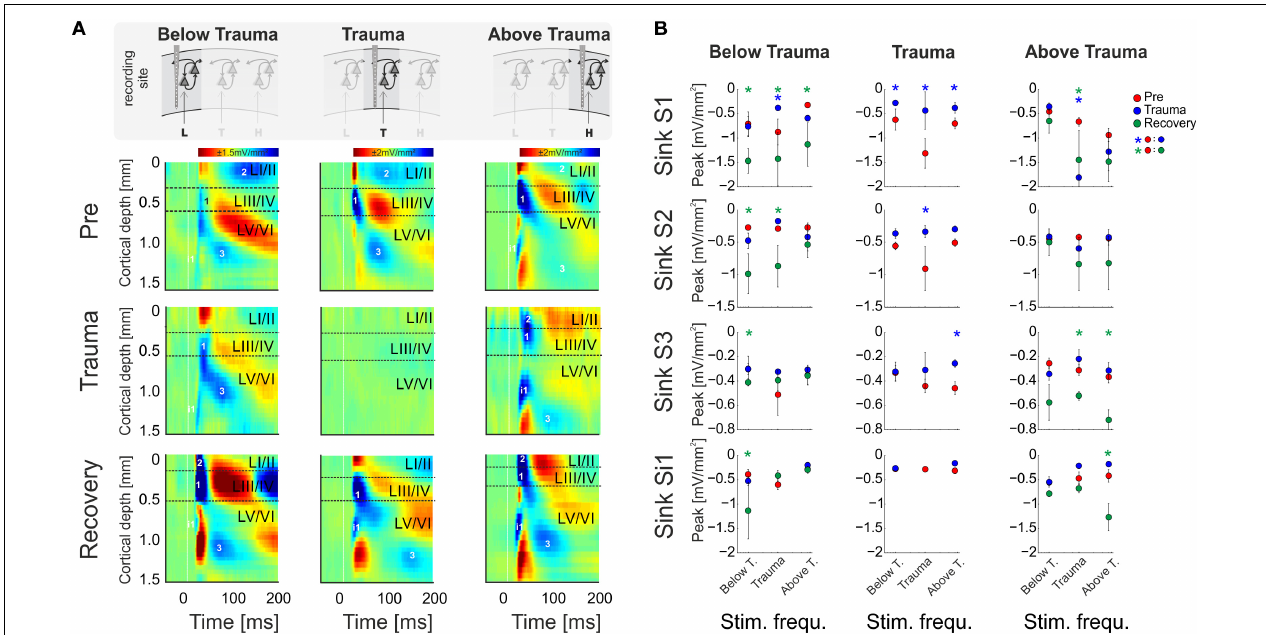
FIGURE 4 | (A) CSD profiles obtained at a moderate sound level (64 dB SPL) before ( Pre ) and after trauma induction ( Trauma ) as well as after 4–6 weeks of recovery ( Recovery ) for all three categories of recording sites, viz. with BF representations below, around and above the trauma frequency (left to right). Effects of sound trauma induction on respective sink components S1, S2, S3, and iS1 are shown for stimulation with the BF from pre-measurement. (B) Quantification of sink peak amplitudes prior to (red), after trauma induction (blue) and after 4 weeks of recovery (green) at the different recording sites and after stimulation with varying sound frequencies (Low, Middle, High). For statistical results based on an rmANOVA and further explanation the reader is referred to the main text and Tables 3.6–3.8 . Blue and green asterisks mark significant differences between groups identified by post hoc paired-sample Student’s t -test based on a Bonferroni-corrected level of significance due to 9 post hoc tests for each sink of α * = α /9 = 0.00556. Comparisons without asterisk are hence not significantly different